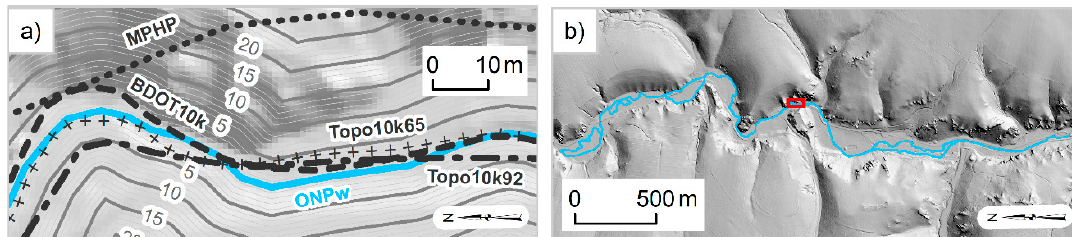
Figure 11. Fragment of part 6 of the Pr ˛adnik River (Figure 12). ( a ) Comparison of the SWRS layer (dashed black line) from the BDOT10k base, vectorised layer from topographic map Topo10k92 (dot-dashed black line) and Topo10k65 (line in“ + ") and layer from Map of the Hydrographic Division of Poland (MPHP) database (dotted black line) to the ONPw watercourse layer (blue line). Magnification compared to the reference scale of 1:10,000 approximately 8.3 times. ( b ) Location of the presented fragment in comparison to the research area. Red rectangle on the ( b ) figure represents ( a ) fragment in comparison to the research area.